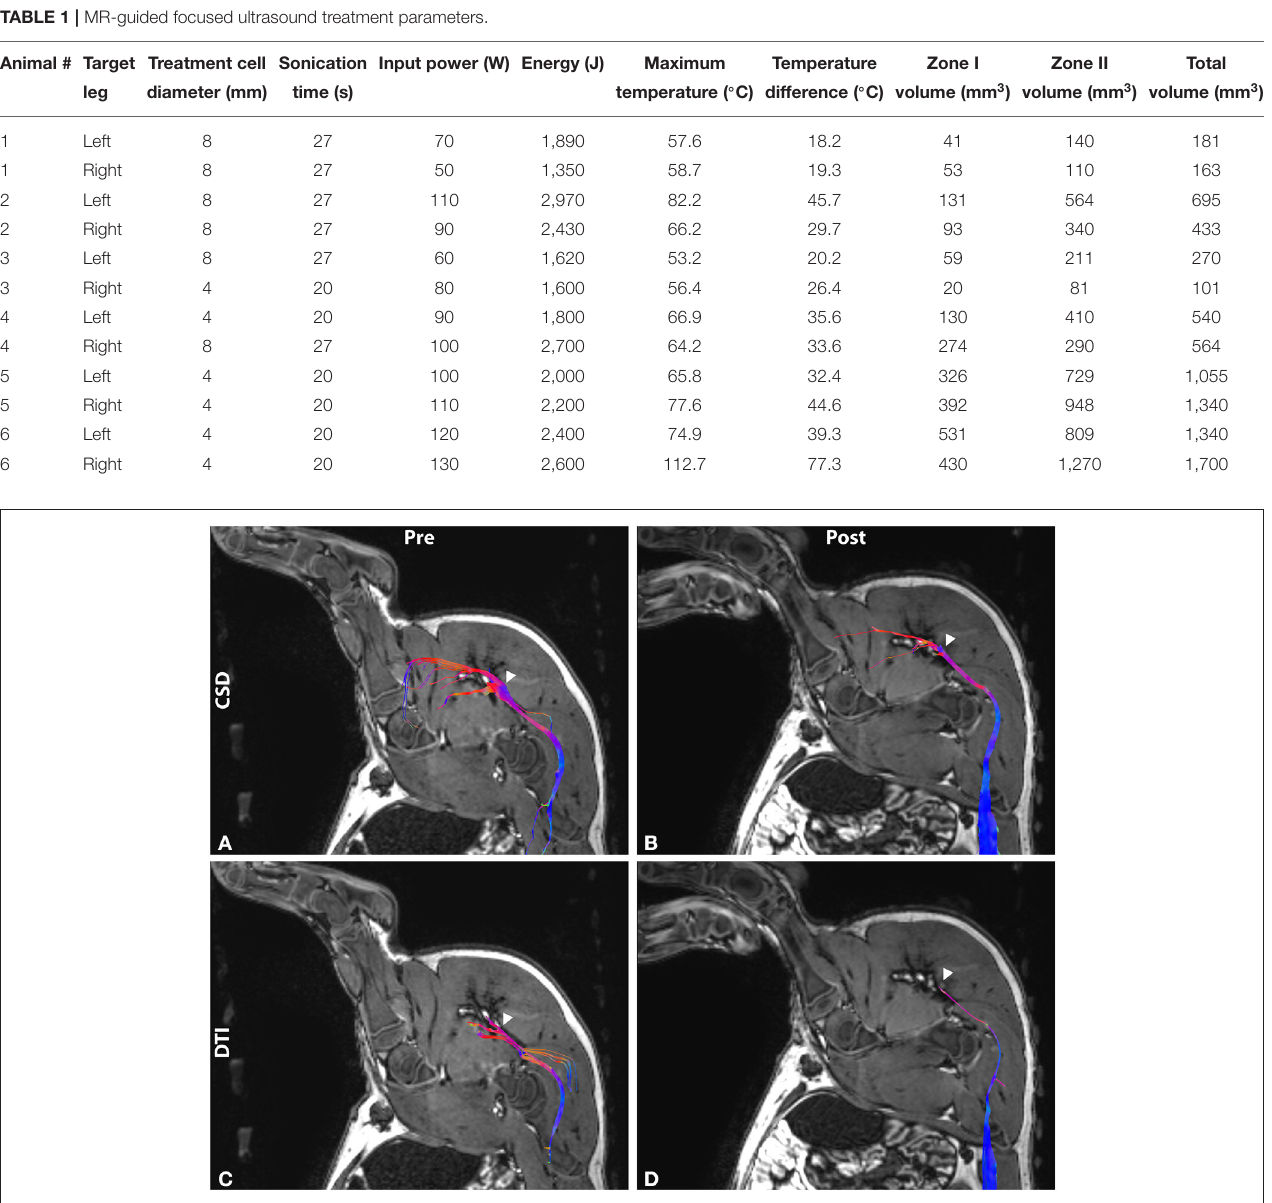
FIGURE 2 | Tractography before and after MRgFUS treatment in sagittal view. Tracts are reconstructed using (A,B) constrained spherical deconvolution (CSD) and (C,D) diffusion tensor imaging (DTI) methods. Tracts are overlaid on T1-weighted images and colored by orientation: anterior-posterior (blue); superior-inferior (red); left-right (green). Arrowhead indicates treatment